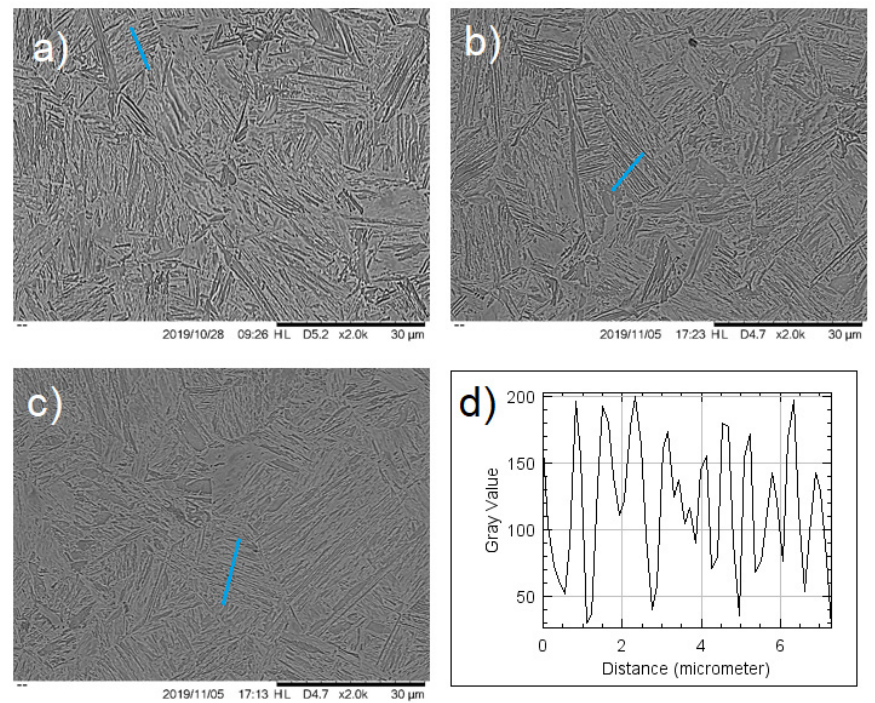
Figure 5. Micrograph of middle zone for the deformed (1100 °C) and quenched 8620 steel bar at the center ( a ), the middle ( b ) and near the surface ( c ), and lamellar spacing measurement at the center ( d ).